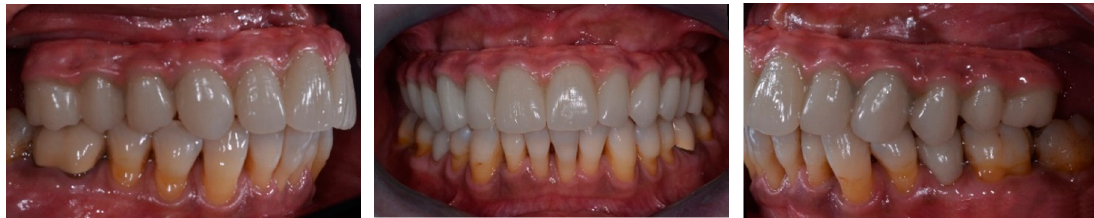
Figure 8. Definitive intraorally screw-retained restorations.